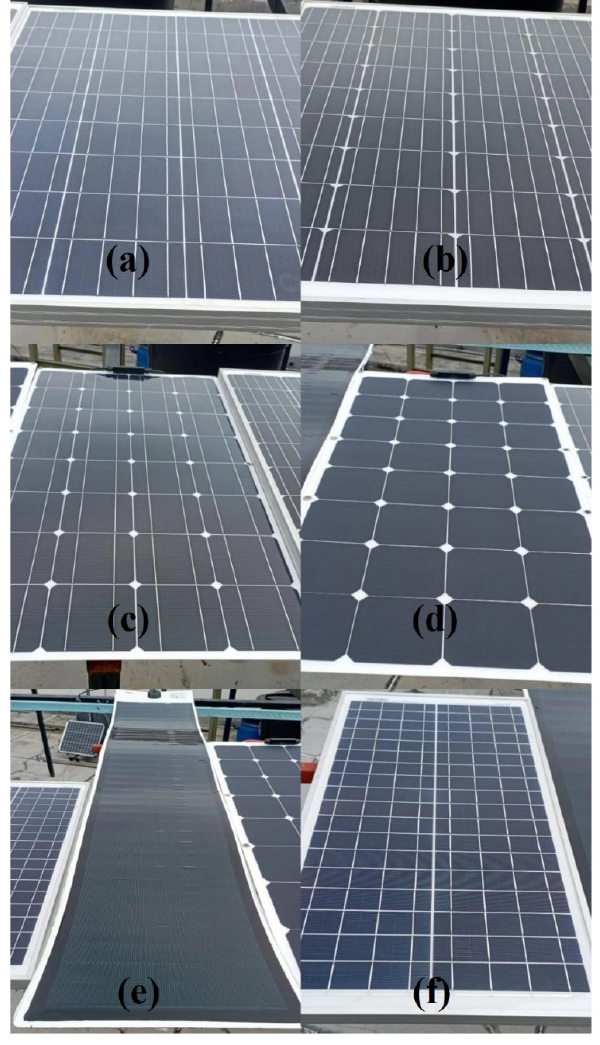
Figure 1. ( a ) Polycrystalline panel, ( b ) monocrystalline panel, ( c ) flexible mono-panel, ( d ) thin-film amorphous panel, ( e ) CIGS solar panel, and ( f ) flexible back-contact mono-panel. The Prova 1011 solar system analyzer was used to measure the PV module perfor- mance (IV curve), FF, P m (V m and I m ), and efficiency under different test conditions. The instrument connects with a wireless irradiance meter and thermometer to collect the irra- diance and cell temperature under the test conditions for the PV modules, as shown in Figure 2. Moreover, the device can calculate the efficiencies and the maximum power un- der test conditions by saving the specification of the PV module (area, V oc , and I sc ) by con- necting the device with a special software program for the device. After that, a consider- able number of IV curves at different irradiance and temperature for the six PV modules are extracted from the device, and the software is used during the MATLAB program’s training process.